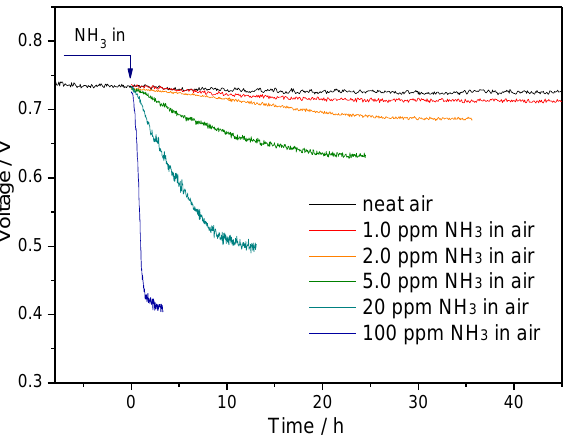
Figure 2. Performance changes of PEMFC after poisoning with NH 3 in air at 500 mA cm −2 . It can be noticed that the cell performance decreased instantaneously when NH 3 was added to the cathode, and the cell voltage drop rate increased with the concentration of NH 3 . It can be also found that the cell voltage decreases operating with neat air as